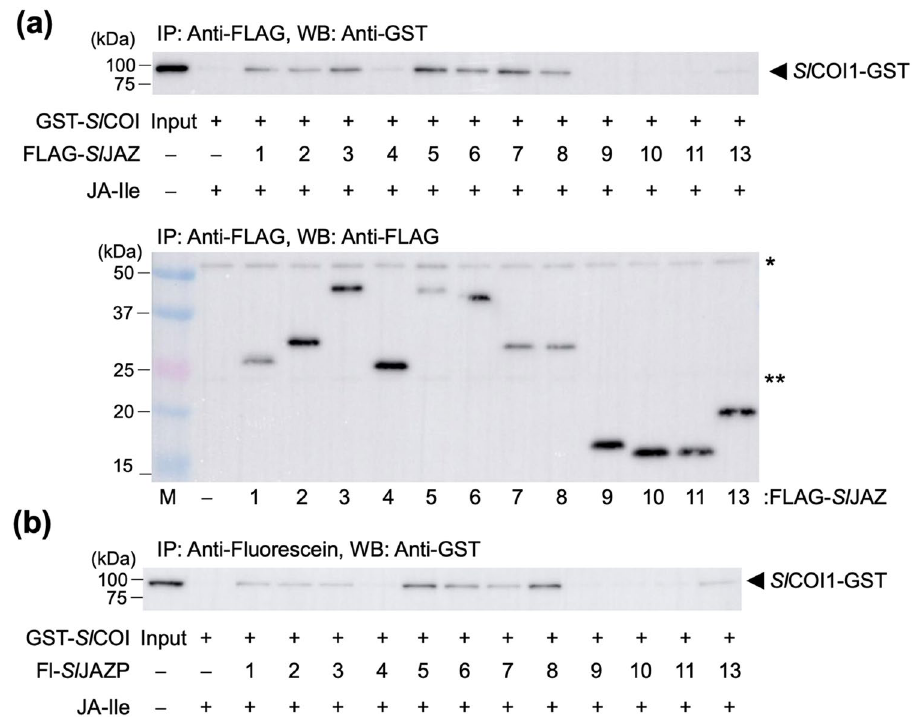
Figure 2. ( a ) Pull down assay of GST- Sl COI1 with FLAG- Sl JAZ (full-length proteins) in the presence of JA-Ile (100 nM). GST- Sl COI1 bound to FLAG- Sl JAZ proteins was pulled down with anti-FLAG antibody and Protein G magnetic beads, and analyzed by immunoblotting (top: anti-GST-HRP conjugate for detection of GST- Sl COI1, bottom: anti-FLAG antibody and anti mouse-IgG HRP conjugate for detection of FLAG- Sl JAZs). *or **show the bands derived from heavy chain or light chain of the anti-FLAG antibody. ( b ) Pull down assay of GST- Sl COI1 with Fl- Sl JAZPs in the presence of JA-Ile (100 nM). GST- Sl COI1 bound to Fl- Sl JAZPs was pulled down with anti-fluorescein antibody and Protein G magnetic beads, and analyzed by immunoblotting (anti- GST-HRP conjugate for detection of GST- Sl